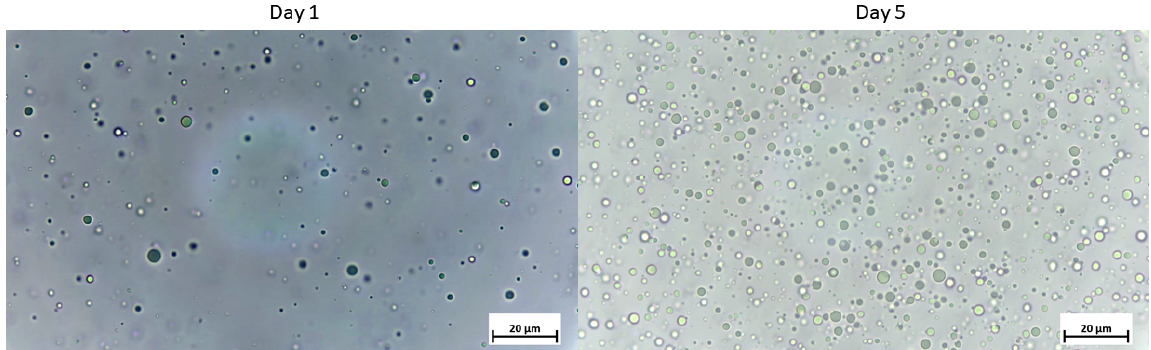
Figure 1. Five-day monitoring of lipid droplet size by optical microscopy (obj. × 100) of the oil emulsion with gum acacia, with